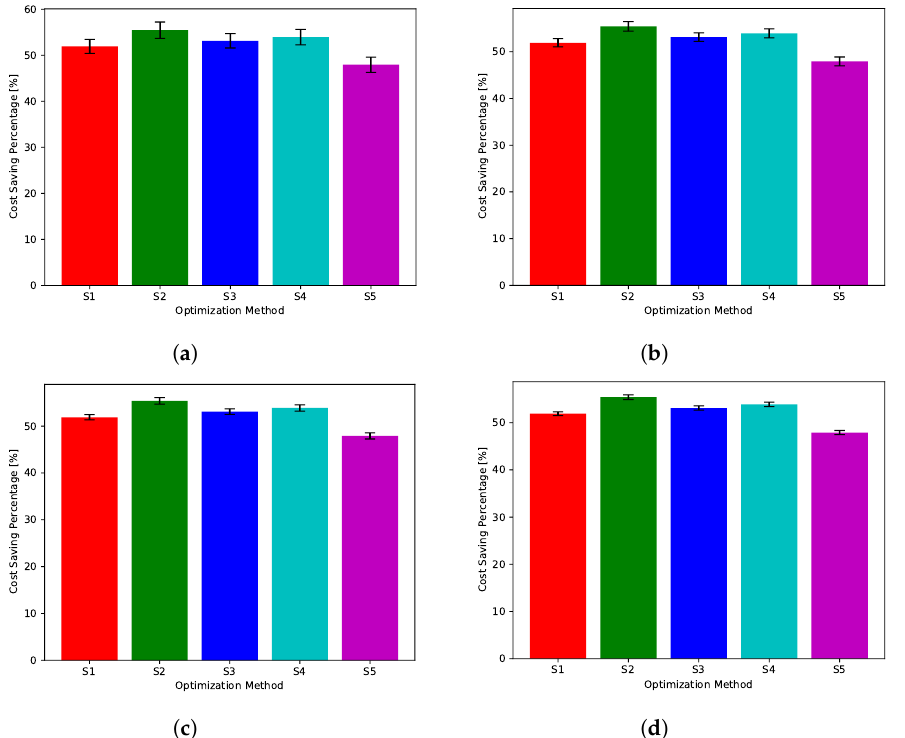
Figure 26. The total cost saving achieved by the proposed greedy scheduler when compared with scheduling policies fixed uncertainty level U 75 . ( a ) Monthly, ( b ) quarterly, ( c ) semiannually, and ( d ) annually.